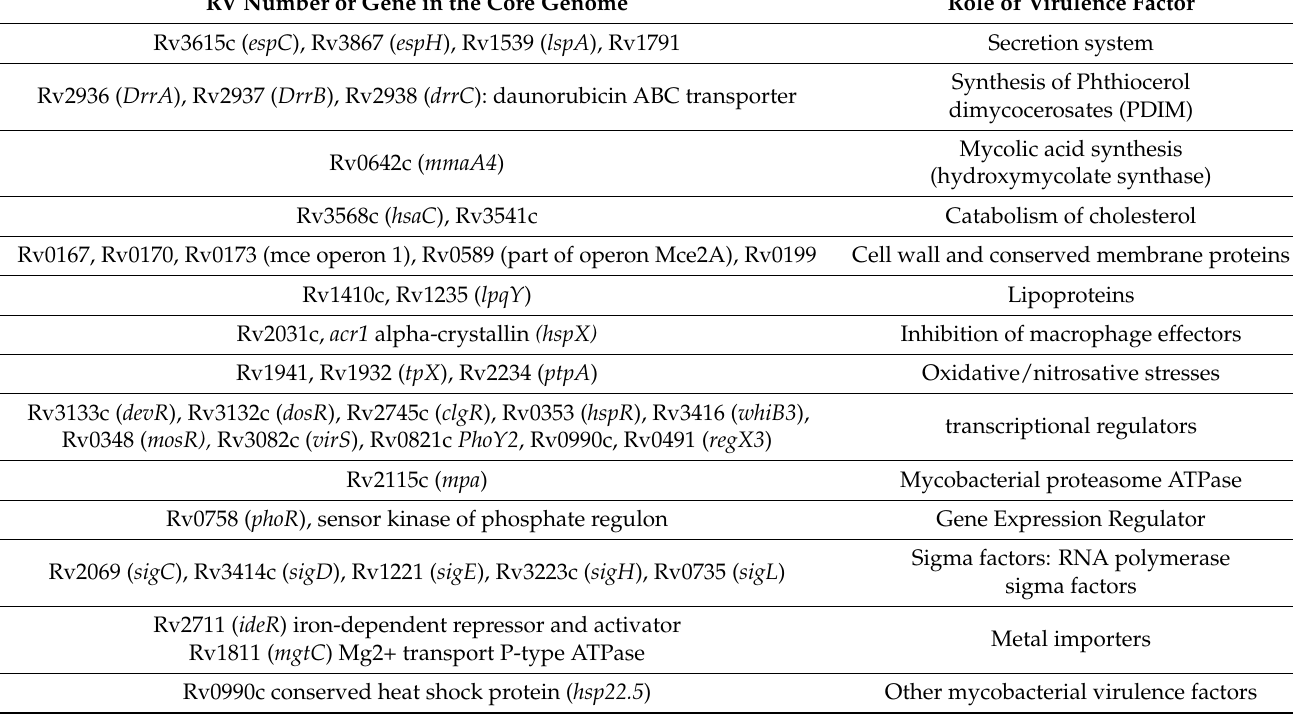
Table 1. Virulence conserved genes in the core genome, according to Forrellad et al. [25]. RV Number or Gene in the Core